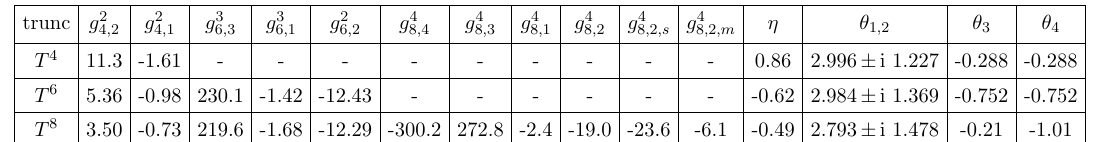
Table 1 . We (cid:12)nd a (cid:12)xed point characterized by two relevant directions. Within the estimated systematic error it appears possible that the third critical exponent, (cid:18) 3 , could become positive under extensions of the truncation. Our notation for the couplings follows that used in [40, 56]: the (cid:12)rst lower index denotes the number of tensors in the interaction, e.g., g 4 denotes all quartic interactions. The second lower index denotes the number of connected components of an interaction. The upper index indicates the number of \melonic" parts it includes. Melonic refers to the fact that the interactions are characterized by a summation over three of the four distinct indices of neighbouring tensors, leading to the distinct (1-index)-(3-indices) interaction structure clearly exhibited in (cid:12)gure 4. Additional lower indices denote distinct characteristics of an interaction structure. All other couplings that exist at quartic, hexic and octic order in tensors vanish exactly at the (cid:12)xed point we explore here.